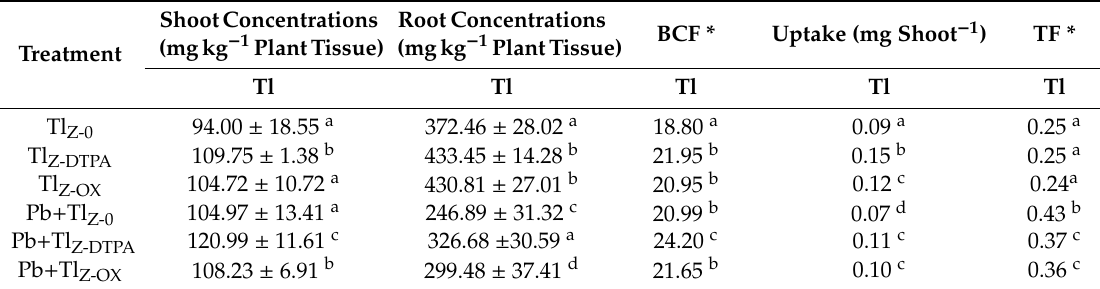
Table 3. Enrichment and transfer coe ffi cient of Tl in maize by chelator-enhanced remediation in glasshouse